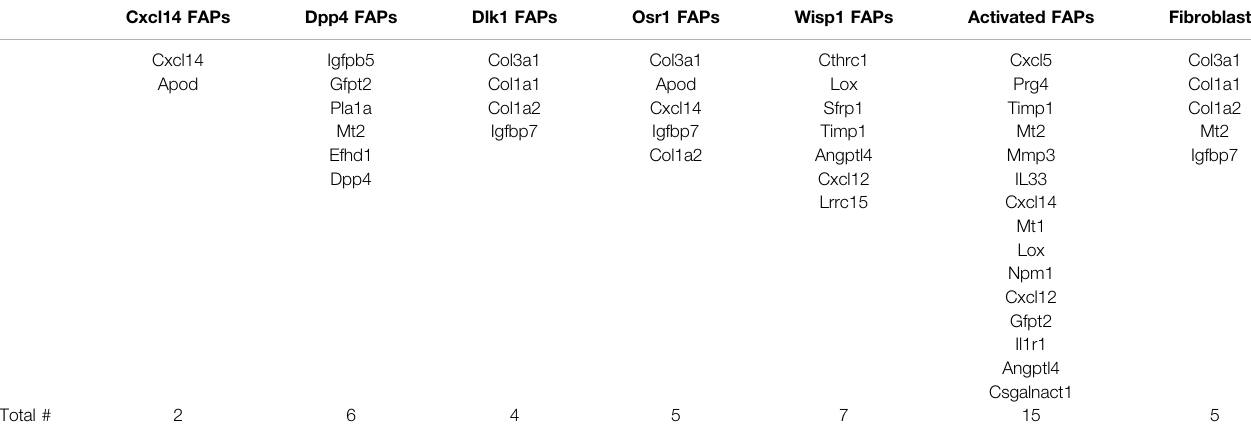
TABLE 2 | Genes from RNA-seq results that overlap with different FAP cell categories. Genes that appeared in RNAseq data from each FAP category identi fi ed by Oprescu et al. (2020). The category of FAPs with the most overlapping genes was activated FAPs, with 15 genes, followed by Wisp1 FAPs with seven